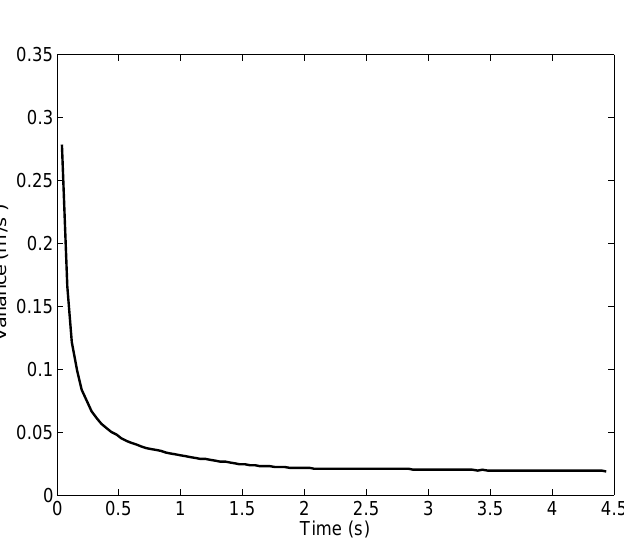
Figure 14. Acceleration fusion result.